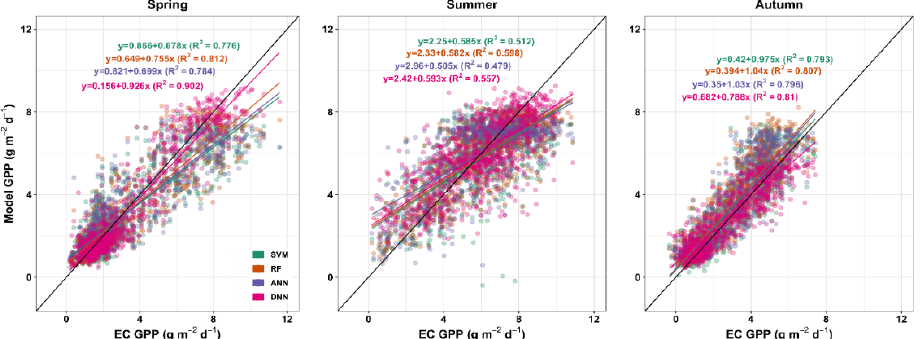
Figure 10. Comparisons between spring, summer, and autumn for the gross primary productivity (GPP) observed vs. predicted by artificial intelligence (AI) models.